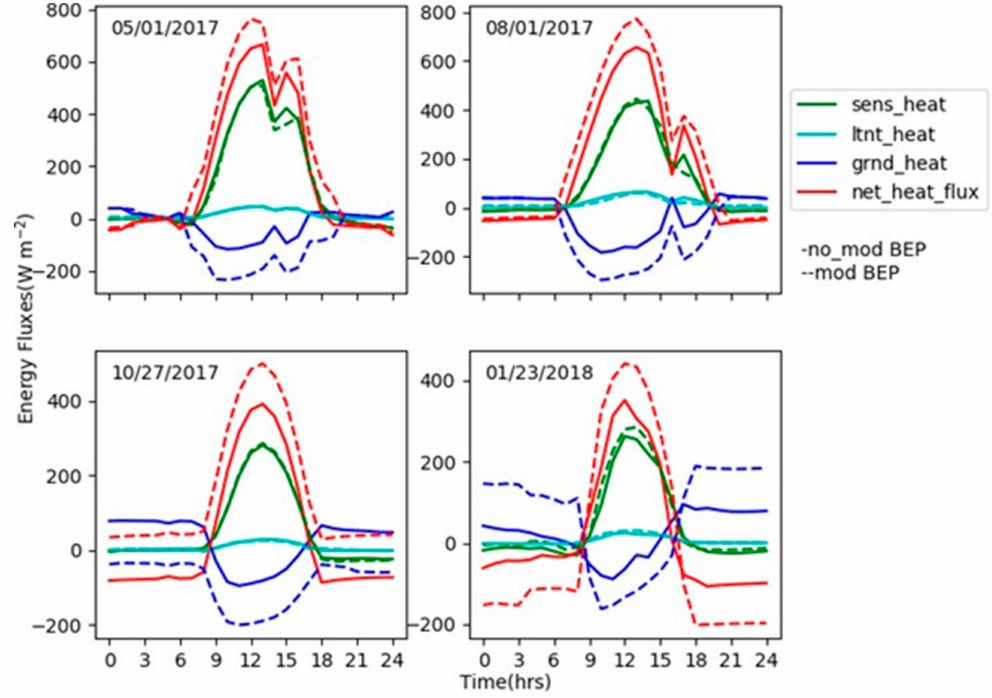
Figure 7. Heat fluxes and net fluxes computed from the energy budget for four days. The unit is Wm −